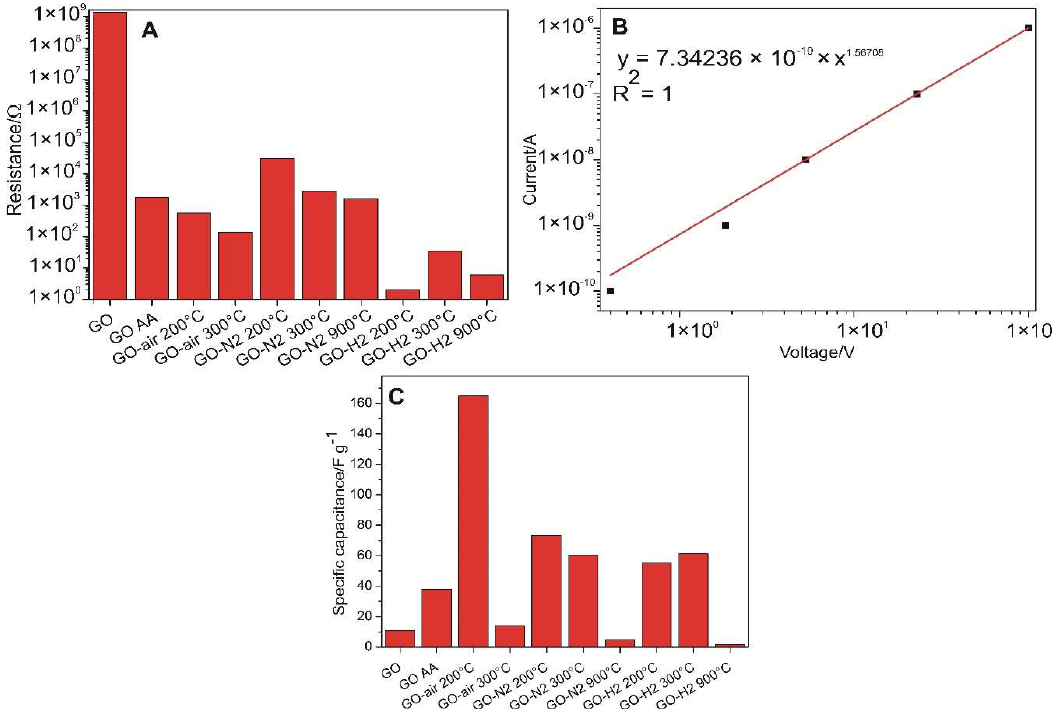
Figure 8. Measured resistance values for the samples ( A ), the current-voltage relationship for the bare GO ( B ) and the specific capacitances calculated from the cyclic voltammograms obtained in 0.5 M H 2 SO 4 ( C ). Nanomaterials 2020 , 10 , x FOR PEER REVIEW 12 of 16